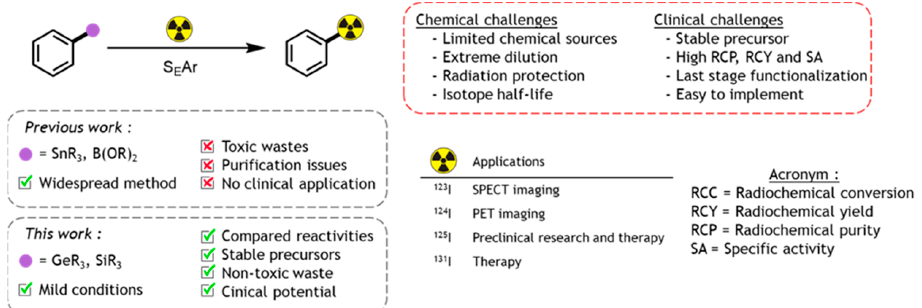
Figure 17. An overview of radio-iodination process.